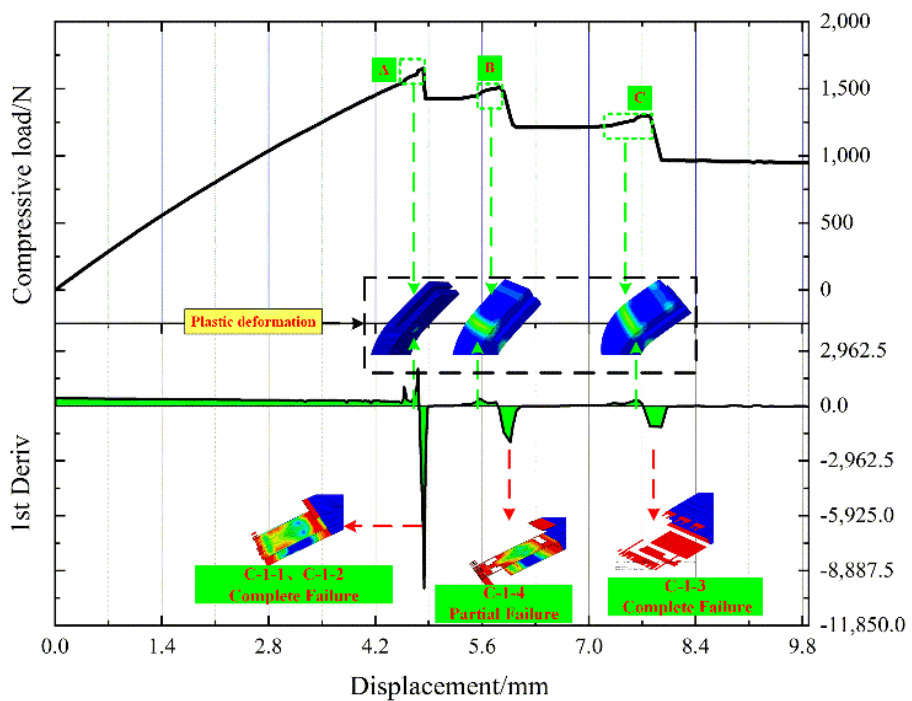
12 of 21 Figure 11. Load–displacement curves for L-joints with a bond length of 25.00 mm. Figure 12 shows the load–displacement curve and its first-order differential curve of the L-joint compression simulation. Observing Figure 11, no matter the experimental or simulated compressive load, there is an obvious plateau before the sudden change. There- fore, the load–displacement curve of the compressive simulation is derived, and its first- order differential curve is obtained. A, B, and C in Figure 12, respectively, frame the stable